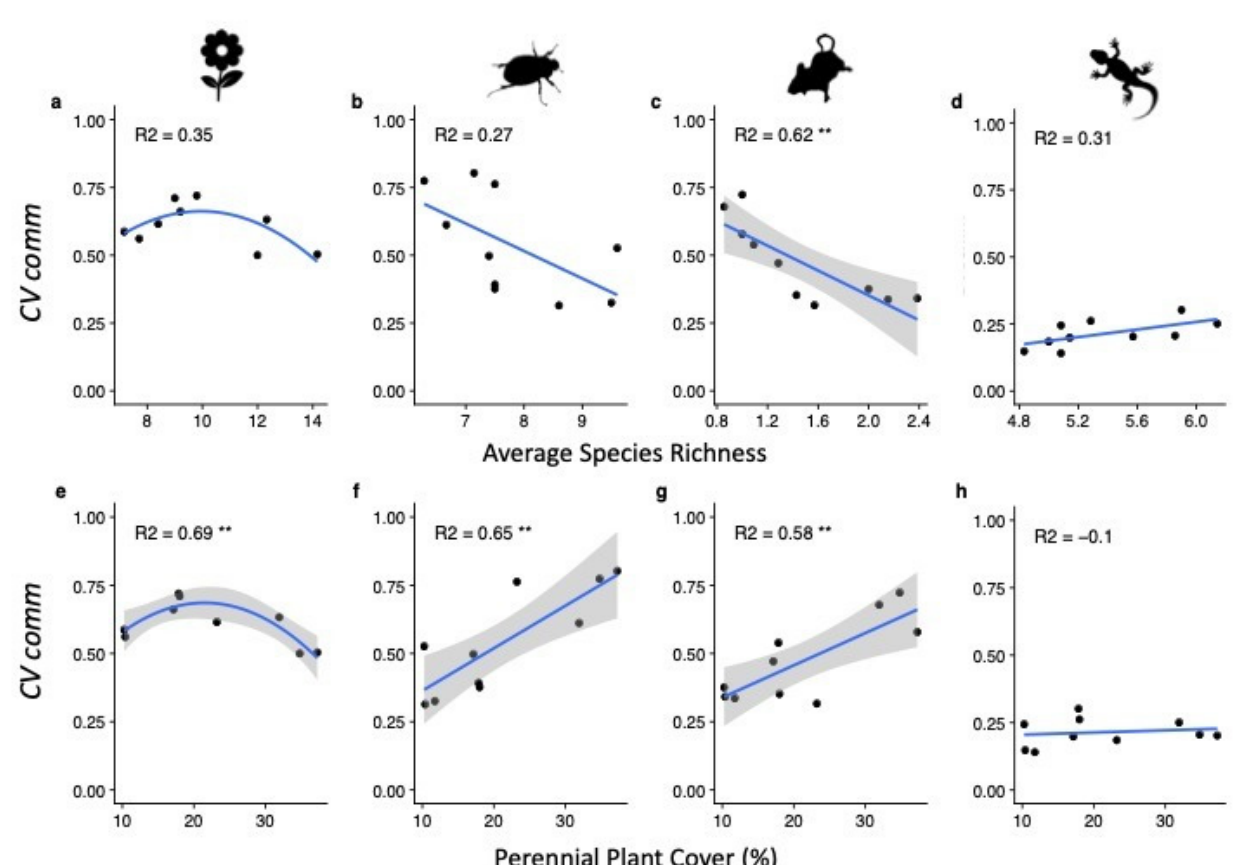
Figure 2. Regressions of ( a – d ) average species richness and ( e – h ) of perennial plant cover (PPC) against community variability ( CVcomm ) for each taxon. Standard error ranges are shown for all significant regressions. Regression lines were plotted using a linear model smoothing function. NB: an increase in CVcomm equates to a reduction in community stability. Explained variation (R 2 ) can only be compared across parameters within each taxon. ** p < 0.01.